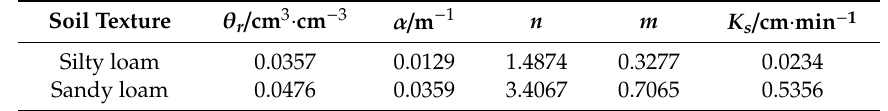
Table 2. Parameters of van Genuchten model for considered soil.